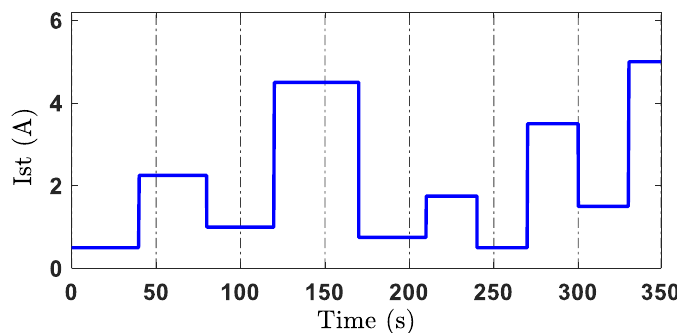
Figure 3. Load current in the simulation.